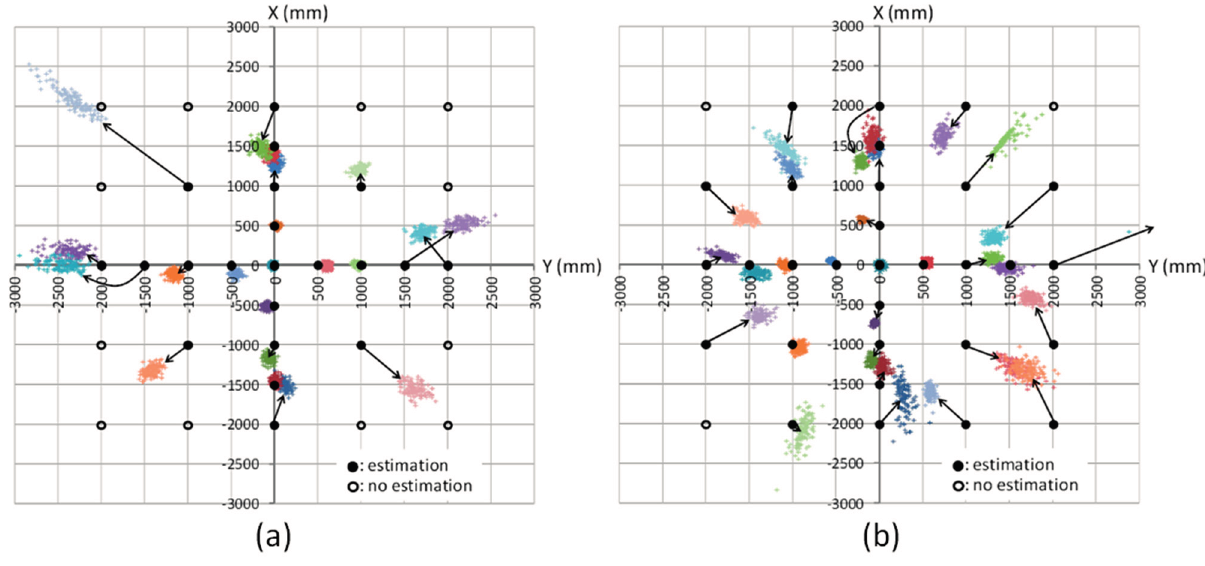
Figure 5. Results of position estimation at each measurement point: ( a ) meeting room and ( b ) corridor.